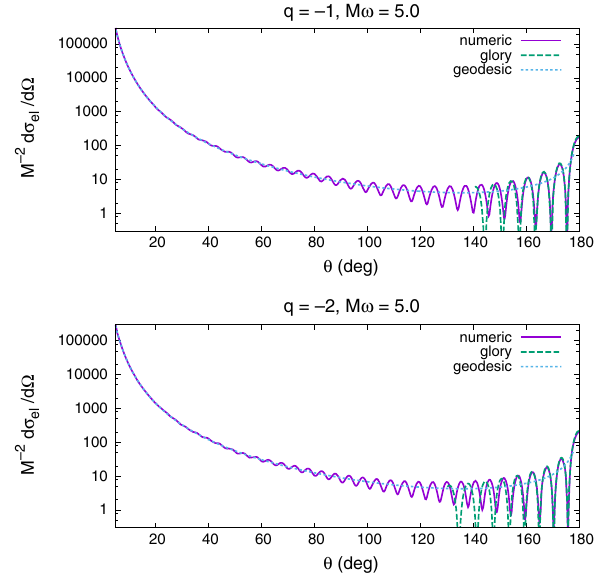
Fig. 6 Comparison of the scalar differential scattering cross section with geodesic and glory approximations for q = − 1 (top) and q = − 2 (bottom)